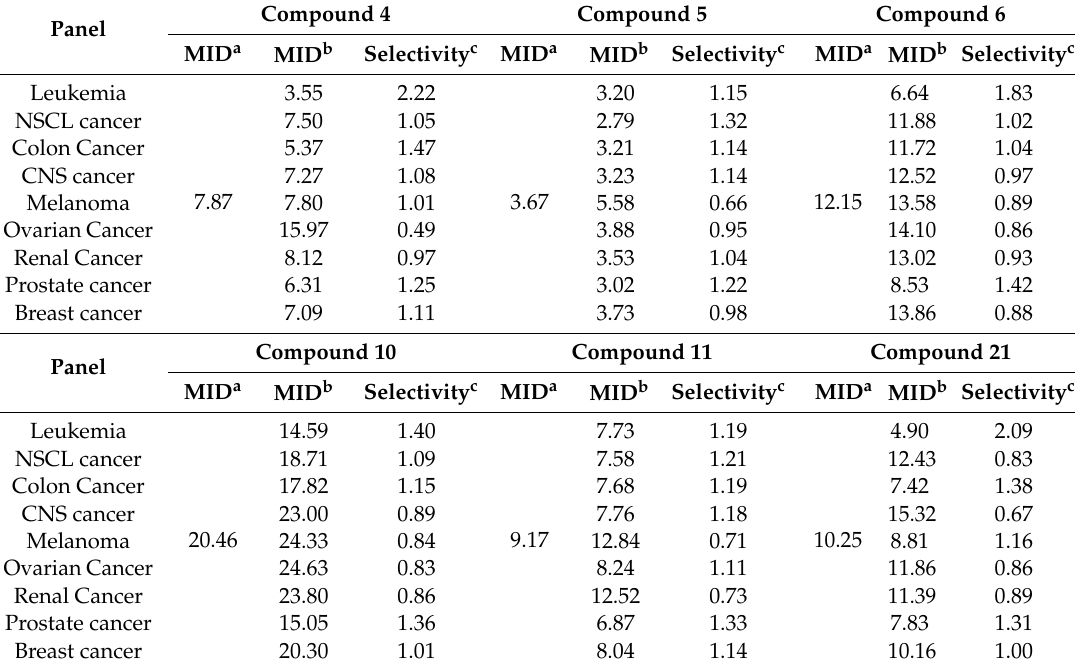
Table 4. Selectivity ratio of the compounds 4–6 , 10 , 11 and 21 towards NCI nine tumor